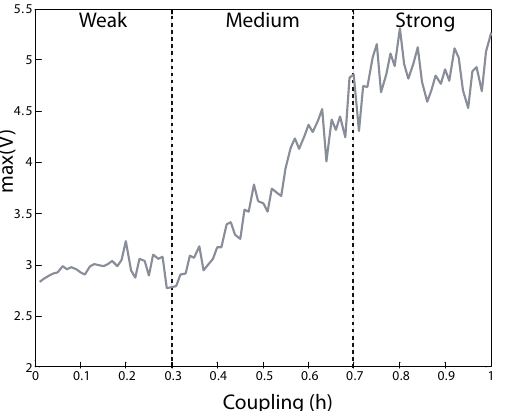
Fig. 7. Maximum value of the variance of the log-perturbations of the fast components y j,i of the two-scale L96 model ( V component of the MVL-diagram) as a function of the coupling parameter h .